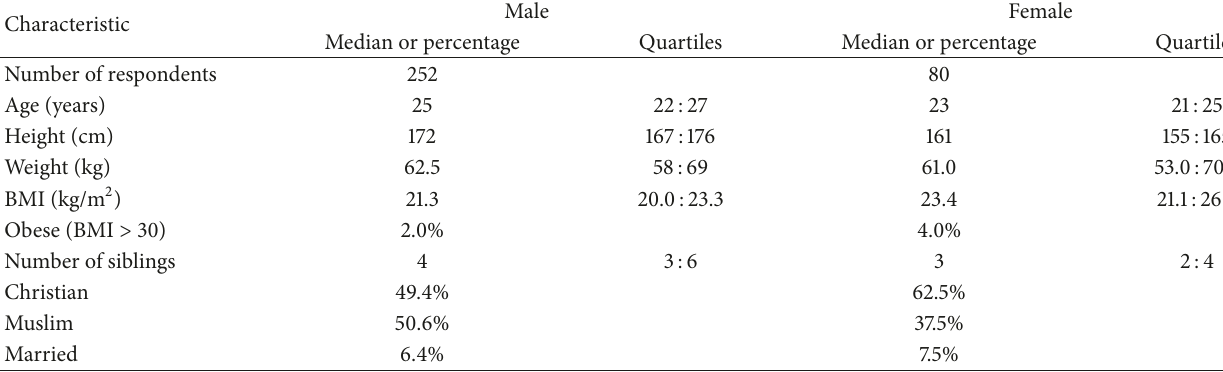
Table 1: Selected characteristics of the student population on Njala campus.